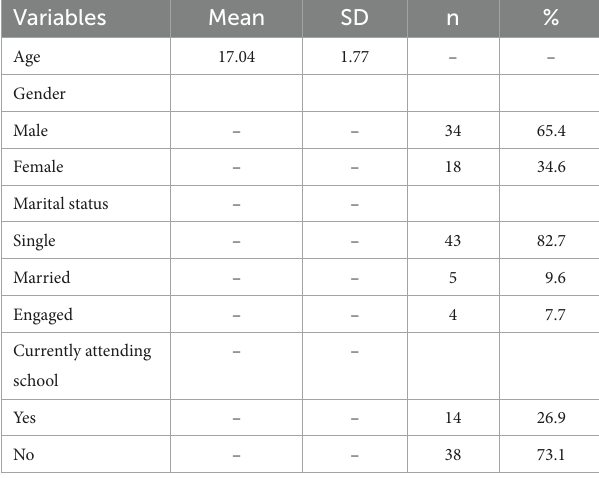
TABLE 1 Sociodemographic characteristics of 52 Syrian adolescent refugees displaced to South Beirut interviewed following the HEEADSSS